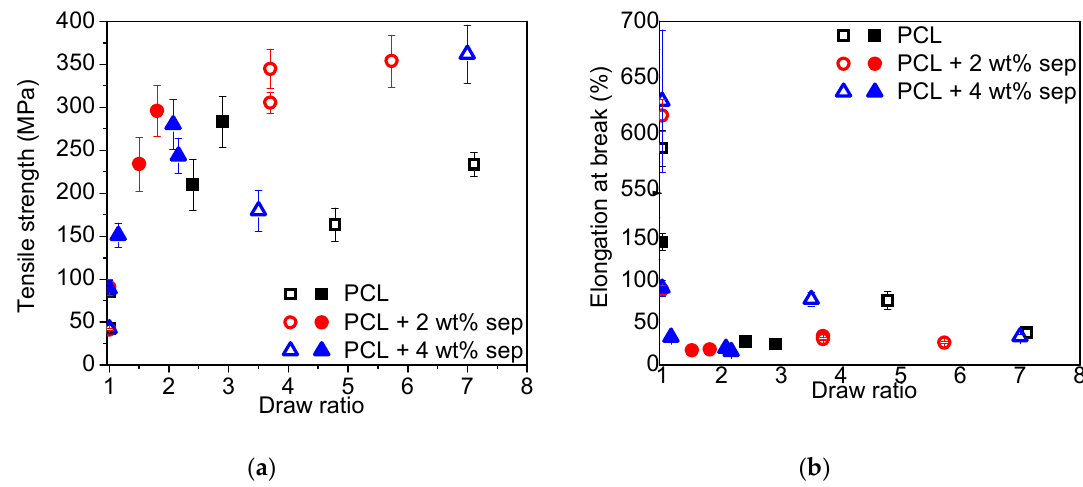
Figure 9. ( a ) Tensile strength and ( b ) elongation at break as a function of the draw ratio of different tapes. Open symbols represent film samples prepared with open chill rolls and closed symbols represent samples prepared with closed chill rolls.